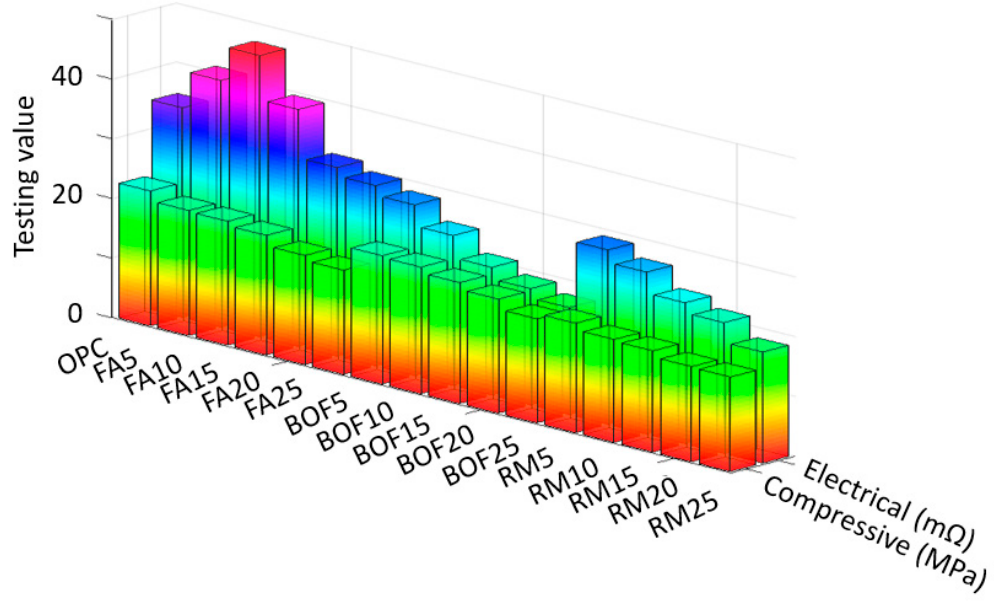
Figure 7. Compressive strength and electrical resistance results for the environment-friendly, self-sensing concrete cured at the age of 7 days.